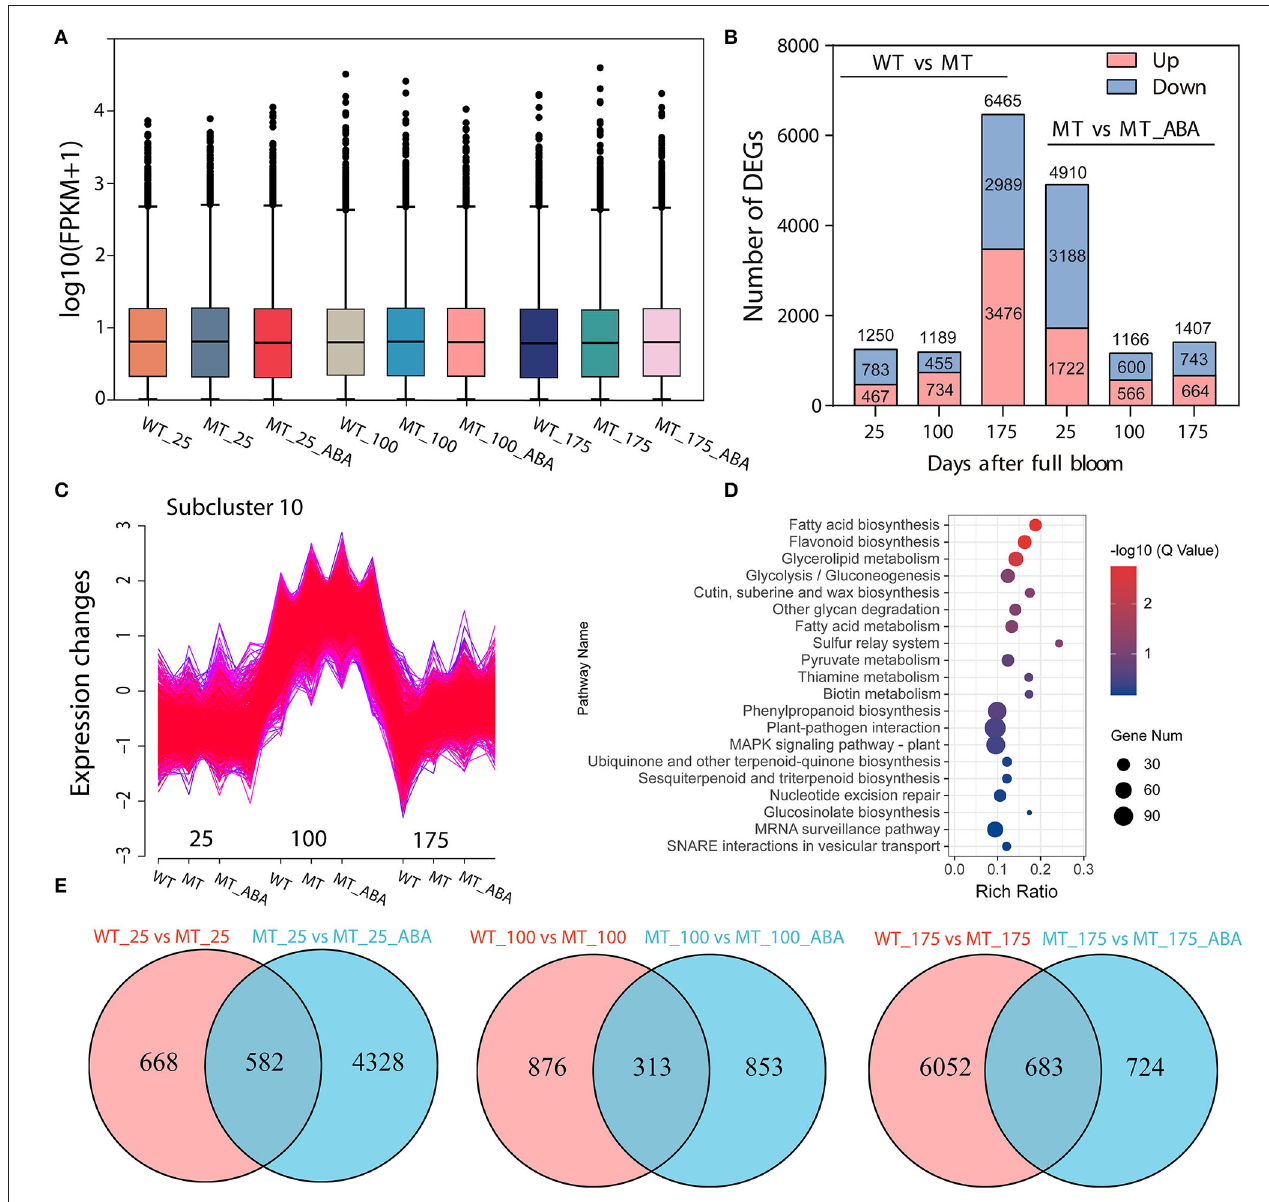
FIGURE 2 | Transcriptome profiles of green (WT) and russet (MT) pear fruit skin. (A) Density distribution profiles of FPKM value to reflect the gene expression pattern of each sample. (B) Column chart of the number of DEGs. red represents upregulated DEGs, and blue represents downregulated DEGs. (C) Cluster analysis of the expression pattern of genes. (D) KEGG enrichment of genes in subcluster 10. (E) Venn diagram of DEGs.